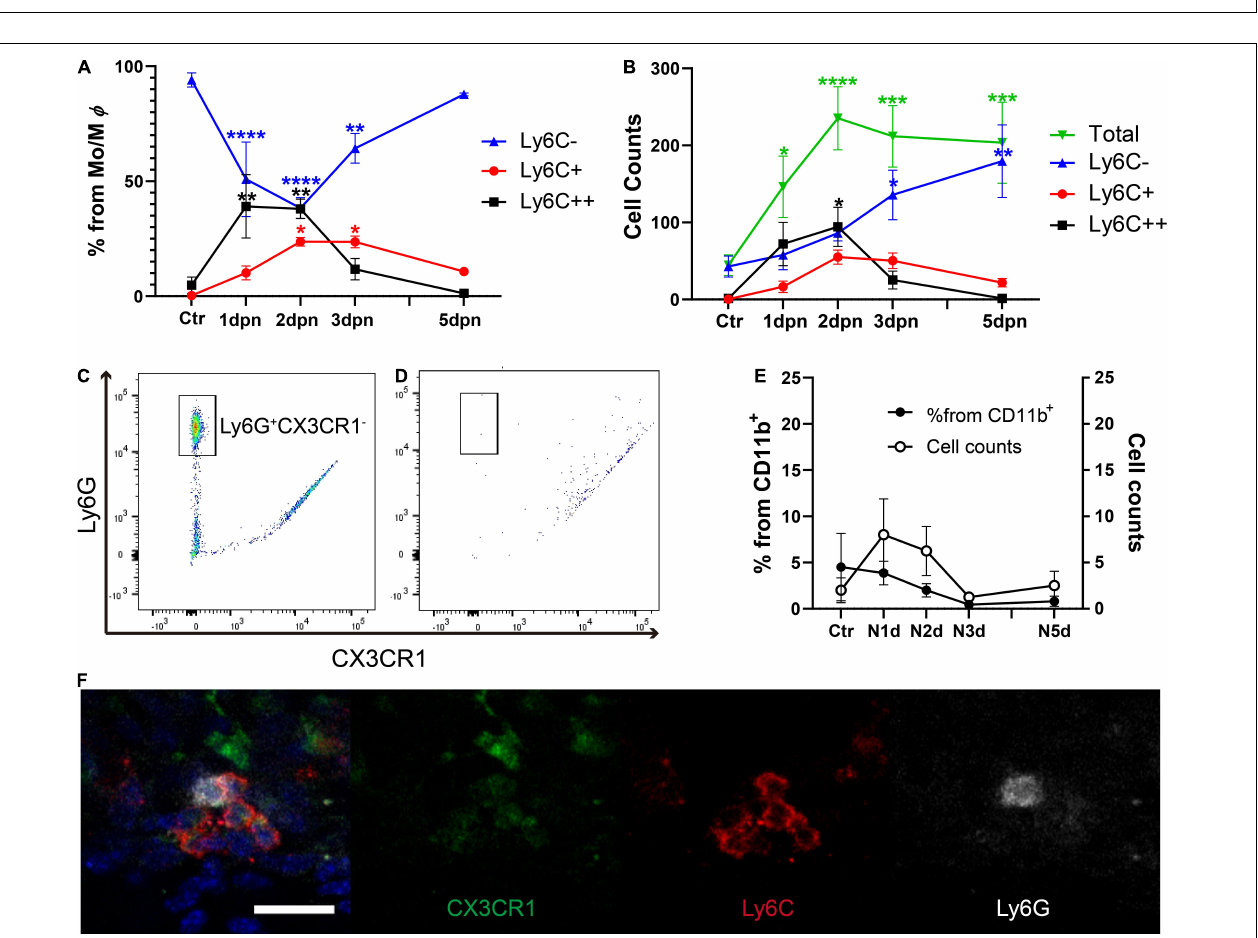
FIGURE 1 | compared to neutrophils (right) in 1 dpn at which the monocytes begin to infiltrate to the cochlea. (F) Effects of clodronate liposome treatment after acoustic overstimulation on Ly6C ++ possible inflammatory monocyte populations in the cochlea after 2 days. (left) Effects of clodronate liposome treatment after acoustic overstimulation on Ly6C – possible resident macrophage populations. (right) Clod : clodronate liposome-treated group. ∗∗ : p < 0.01, ∗ : p < 0.05, ns : not significant. (G) Immunofluorescence study comparing control and clodronate liposome at 2 dpn. White arrows indicate clusters of monocytes. The black box in the light microscopy image located on the left indicates the anatomical location of the immunofluorescence images. Scale bar = 50 µ m.